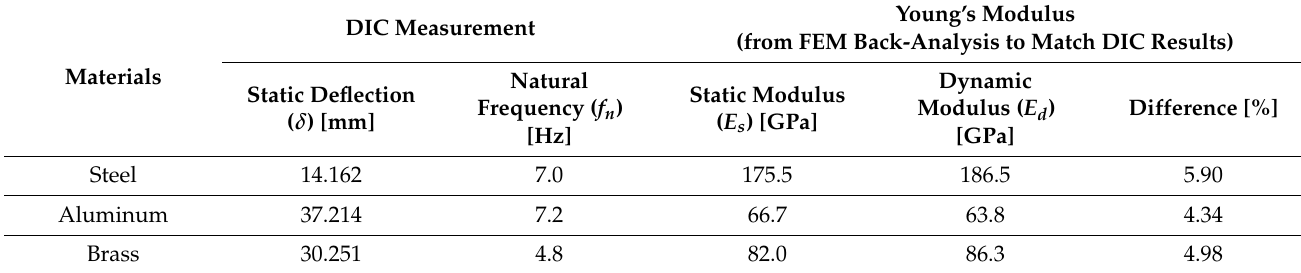
Table 4. Comparison of static and dynamic Young’s moduli of steel, aluminum, and